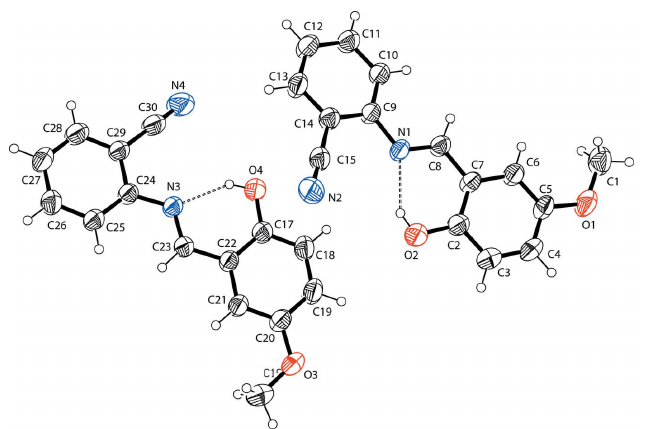
Figure 1 The molecular structure of the title molecule, with the atom-numbering scheme. Displacement ellipsoids are drawn at the 40% probability level. The intramolecular O—H (cid:3)(cid:3)(cid:3) N hydrogen bonds (Table 1) are shown as dashed lines.